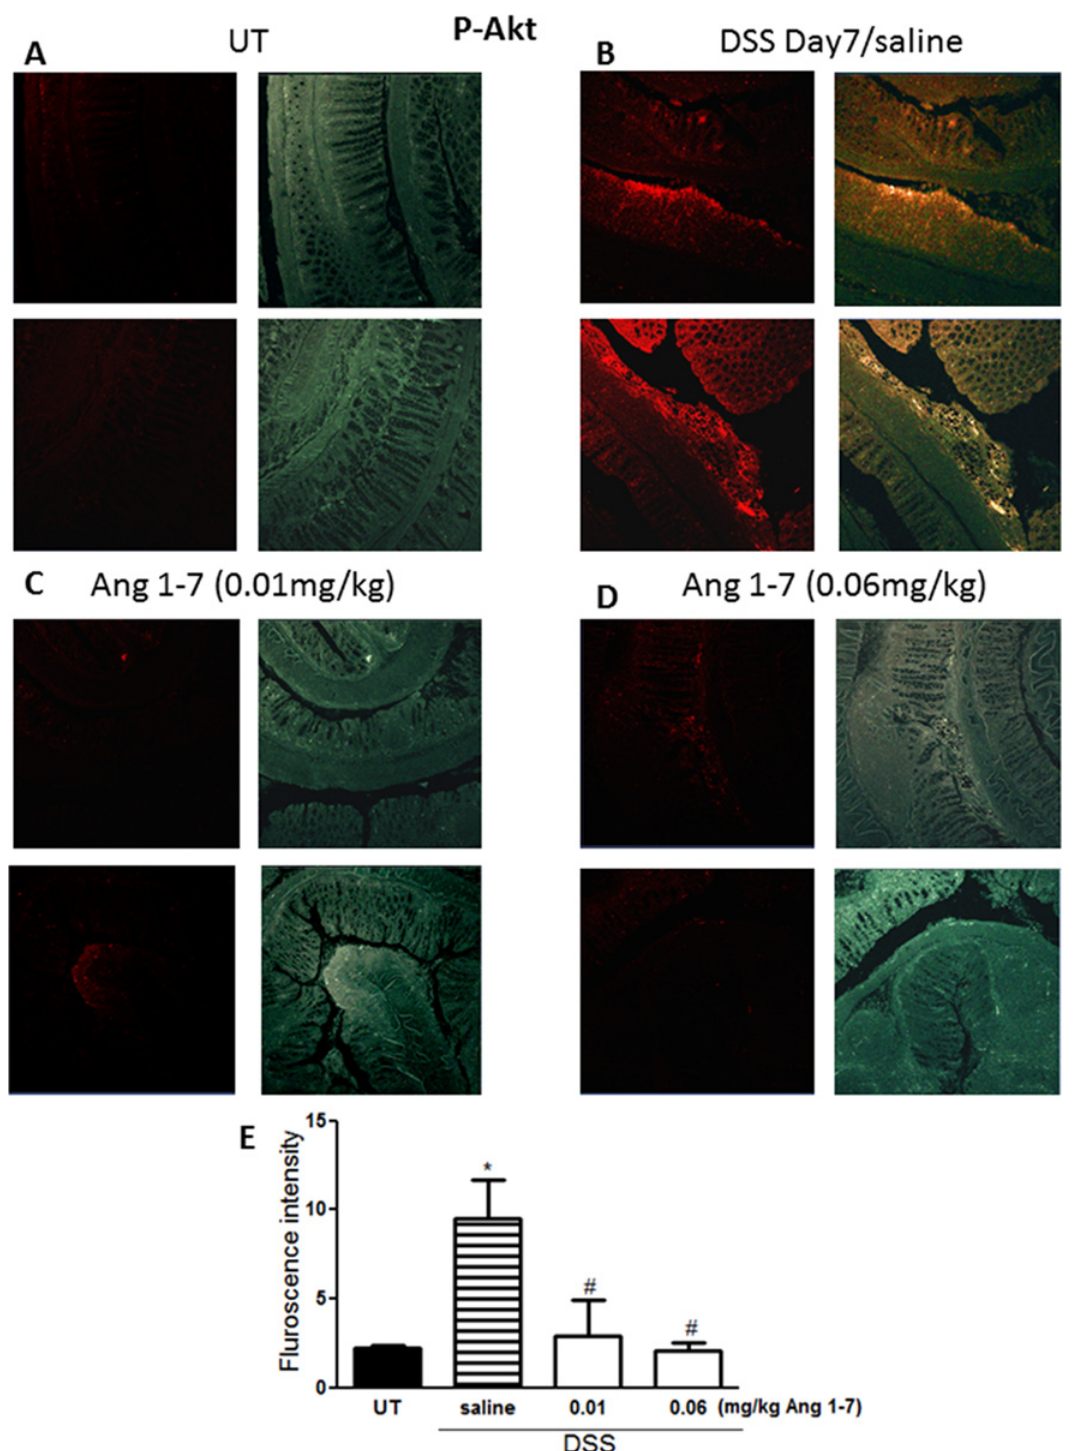
Fig 10. Immunofluorescent detection of phosphorylated Akt in colon sections. Panel E represents quantitative assessment of fluorescence intensity (arbitrary units). Histobars represent means ± SEM for 3 mice in each group. Asterisk denotes significant difference from UT mice, with p < 0.05, and # denotes significant difference from DSS/i.p saline (vehicle) treated mice, with p < 0.05.